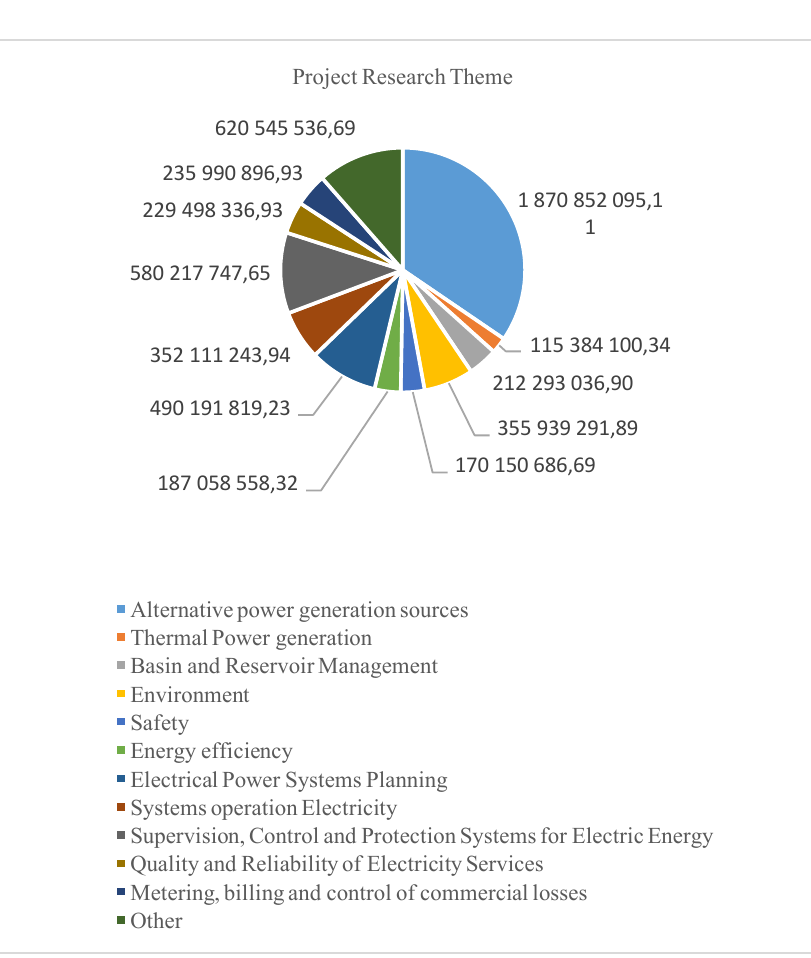
Fig. 2. Distribution of project research theme (ANEEL, march